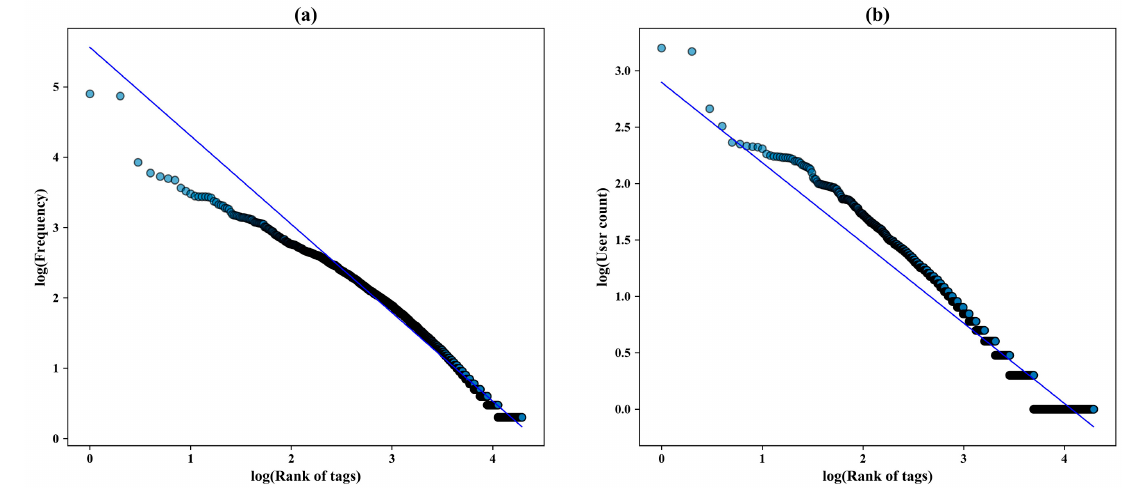
Figure 6. Log-log plots of tags used in the study: ( a ) Log-log plot on the frequency distribution of tags. ( b ) Log-log plot on the number of users using these tags.